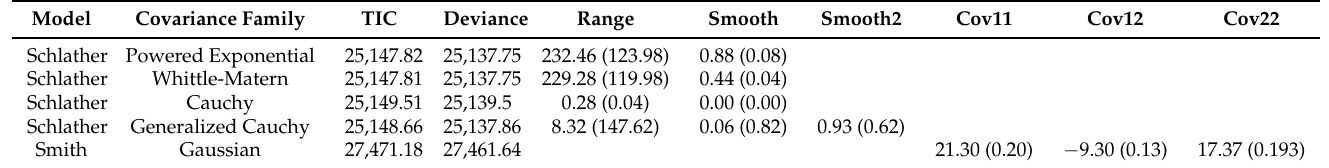
Table 8. Max-stable process fitted to the third cluster of the annual maximum